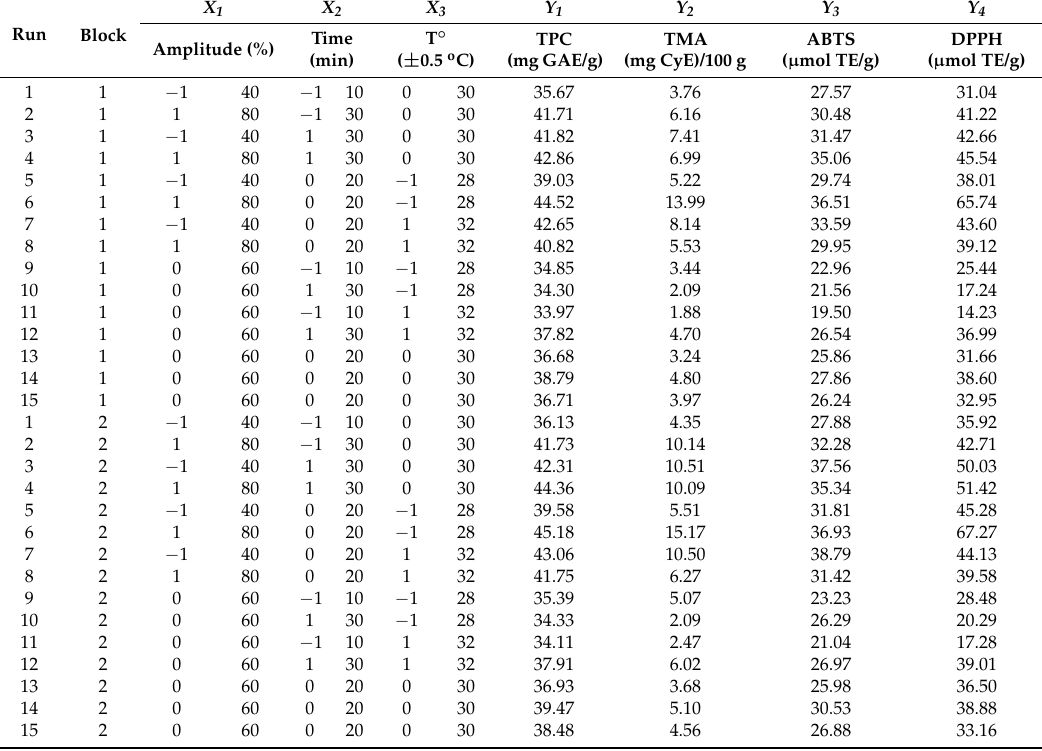
Table 1. Box–Behnken design (RSM 3-level-3-factor-1 replicate) and observed experimental total phenol content (TPC), total monomeric anthocyanin (TMA), and radical scavenging activity (ABTS and DPPH) data from Brosimum alicastrum left-extract.